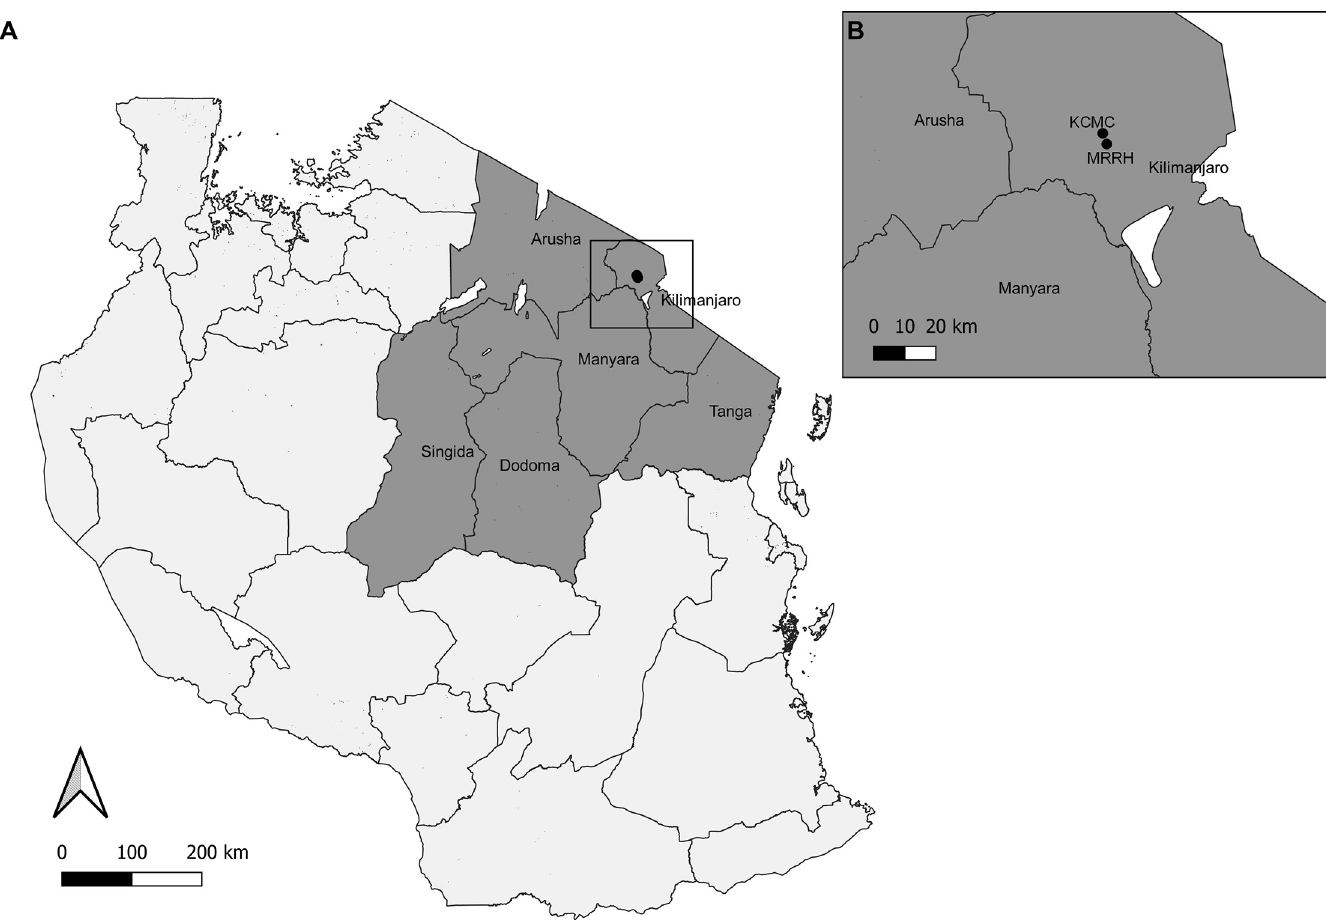
Fig 1. Map of Tanzania sub-divided into regions (A) Regions of Kilimanjaro, Tanga, Arusha, Manyara, Dodoma, and Singida are labeled and Mawenzi Regional Referral Hospital (MRRH) and Kilimanjaro Christian Medical Centre (KCMC) are identified by point markers. (B) Point markers for MRRH and KCMC.